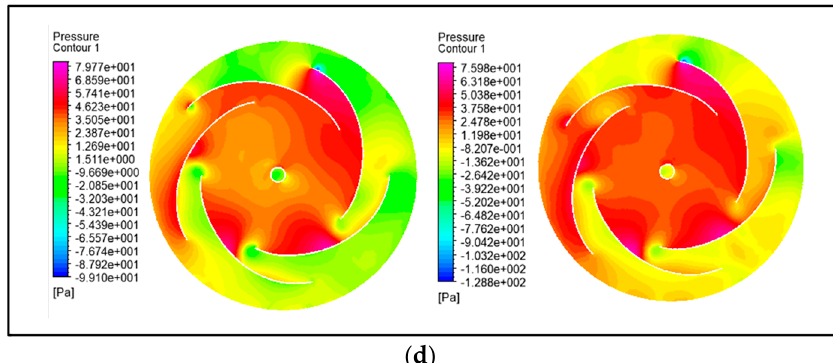
Figure 10. The pressure distribution contour when the number of wind turbine blades is two, three, four, and five respectively. ( a ) The number of blades is two; ( b ) The number of blades is three; ( c ) The number of blades is four; ( d ) The number of blades is five. Figure 11 is a comparison curve of torque generated by one rotation period when the number of blades of the wind turbine is different. As shown in Figure 11, the torque of the two-blade wind turbine is the smallest, and the torque of the other three cases has a small difference in torque. Figure 12 is a comparison curve of wind energy utilization rate when the number of blades is different. From the graph of wind energy utilization coefficient, it can be seen that the maximum wind energy utilization coefficient of three-blade to five-blade is higher, but the duration of the maximum wind energy utilization coefficient of five-blade and four-blade less than three-blade (the range of usable wind speeds is smaller).